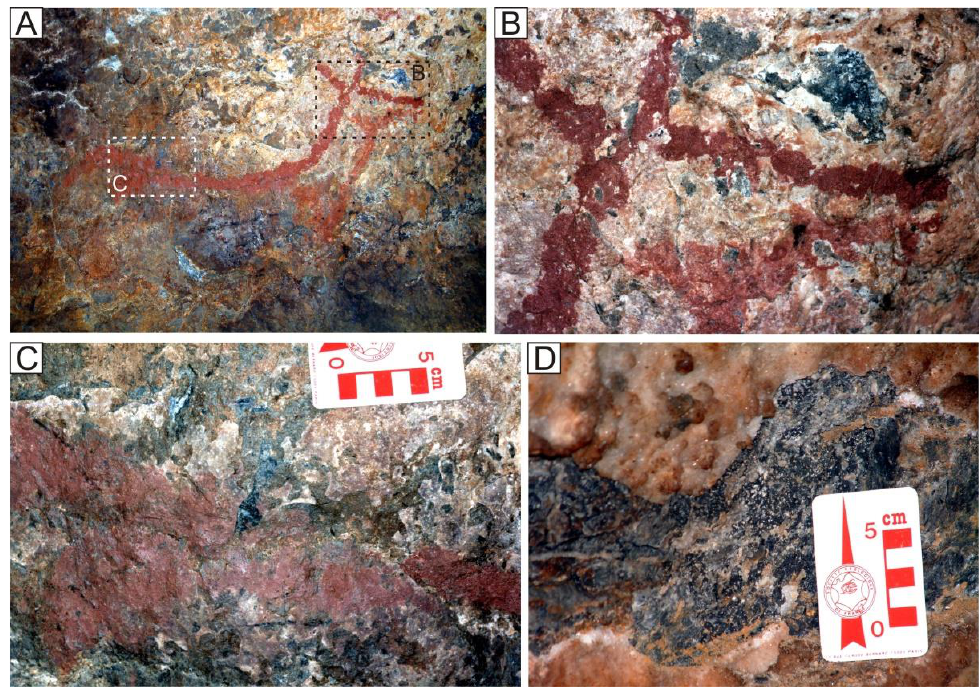
Figure 2. Prehistoric cave paintings found on the walls of Arenaza cave. ( A ) General view of Red Deer in the Paintings Sanctuary. ( B , C ) Detail of the head and the back of the deer painting showing deterioration features (flakes, loss of pigments). ( D ) Detail of painting substrates (host limestone, calcite crust).